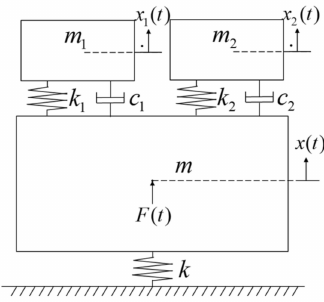
Figure 6. Modeling of dual dynamic absorber and target structure.